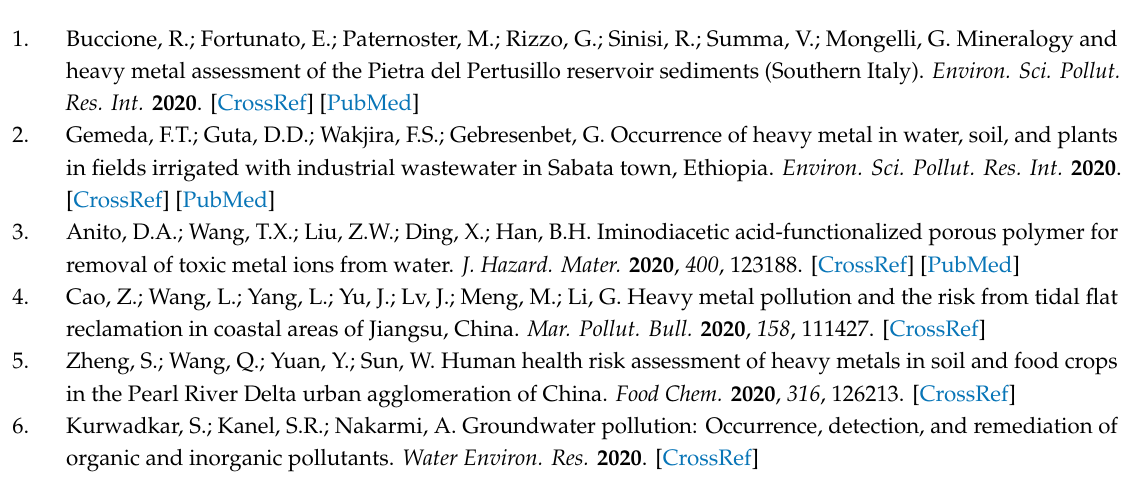
Figure S1: Temkin isotherm model for the adsorption of metal ions onto APBC adsorbent, Figure S2: (a–c) intra-particle di ff usion plots for Cu(II) Pb(II) and Cd(II) at 323 K; (d) D-R model for APBC